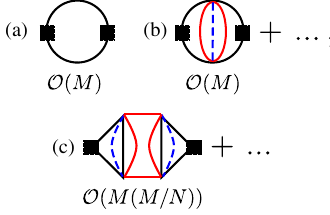
FIG. 2. (a) The uniform current-current correlation bubble used to compute conductivities. The current vertices are black squares and the black lines are conduction electron ( c ) propagators. (b), (c) Additional diagrams forming ladder series, with ladder units of up to three loops, that contribute to the conductivities and are not immediately suppressed by the large N and M limits. The red lines are island fermion ( f ) propagators that do not carry momentum. The dashed blue lines carry momentum and come from disorder averaging of the nontranslationally invariant coupling g x . These diagrams, however, vanish upon momentum ijkl integration in the loops containing the current vertices, for reasons mentioned in the main